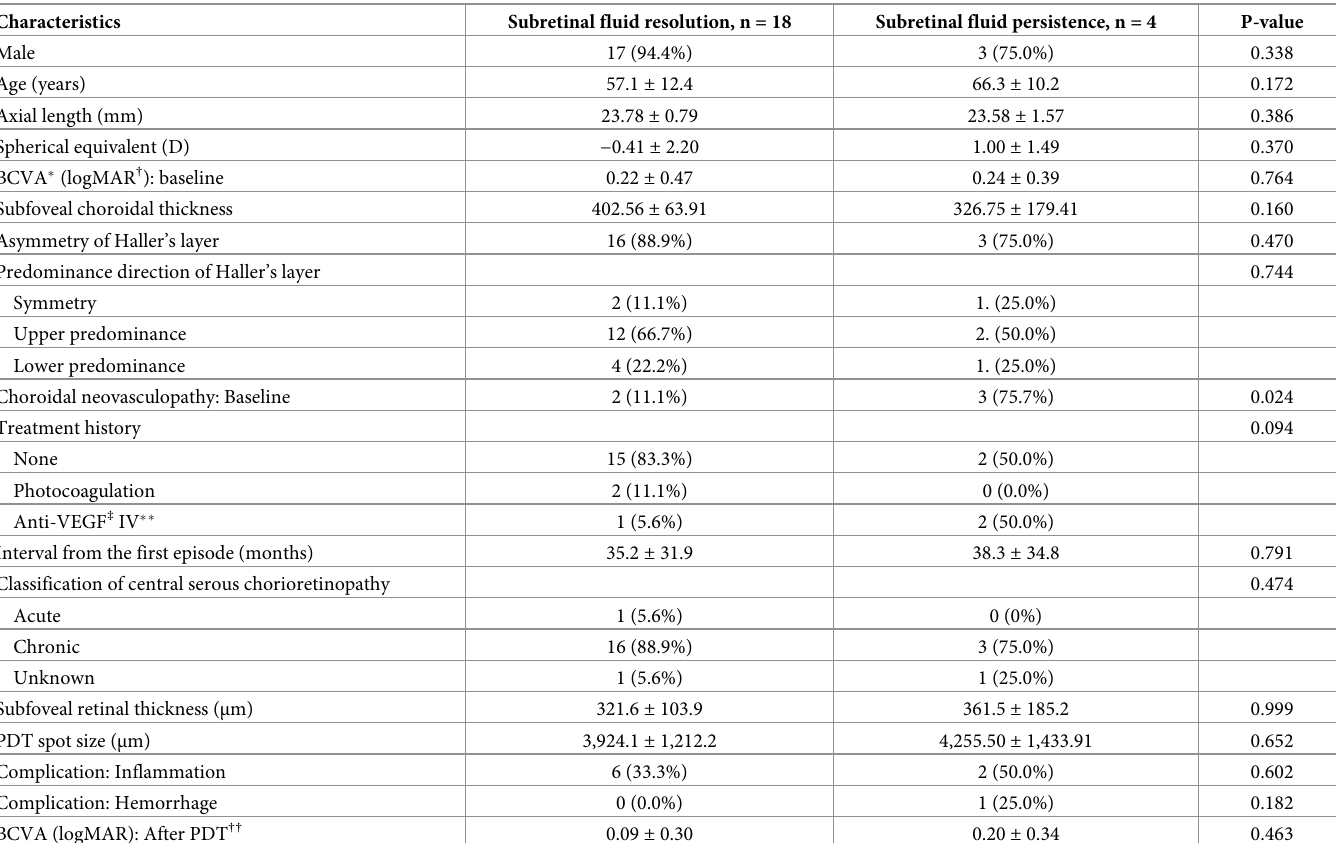
Table 3. Characteristics of patients with central serous chorioretinopathy by treatment